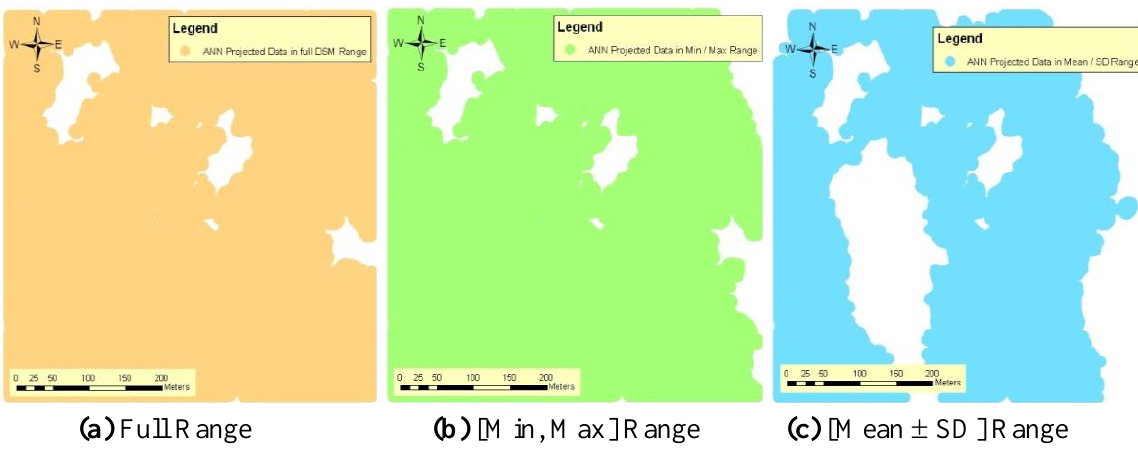
Figure 6. ANN projected DEM data for different DSM data ranges of the T1 test